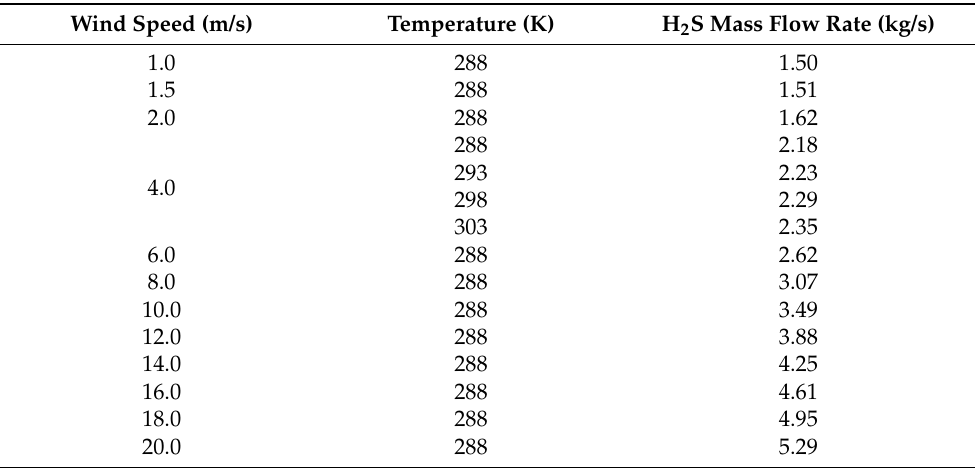
Table 2. H 2 S emission rate at different temperatures and wind